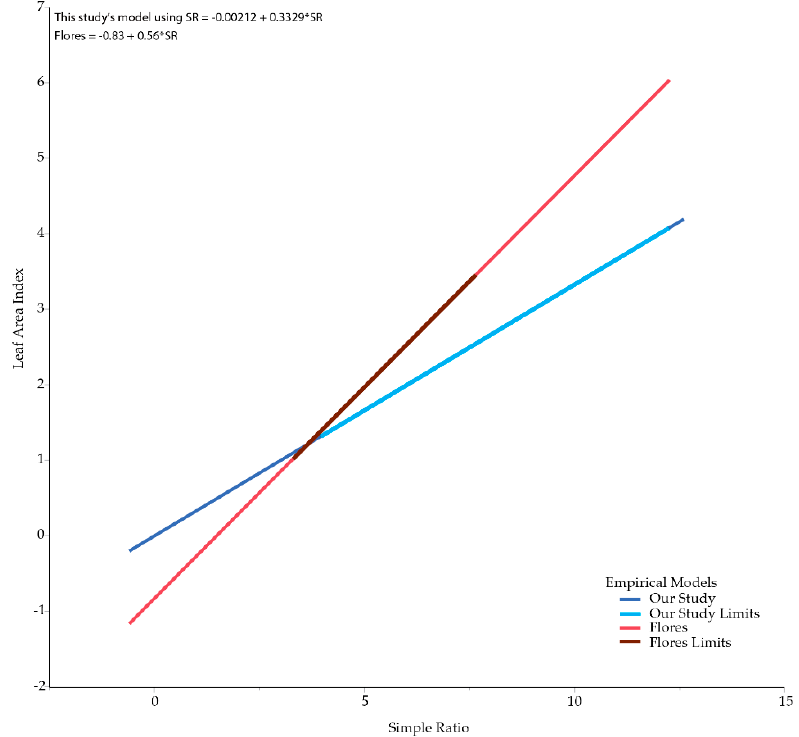
Figure 5. Final models and effective ranges for the two compared models.